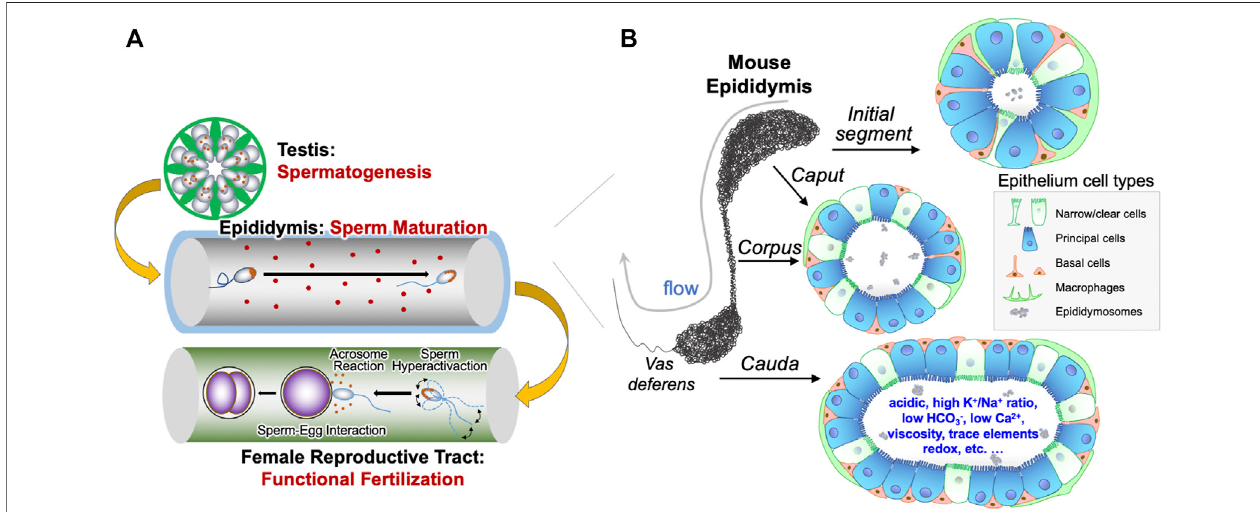
FIGURE 1 | Epididymal epithelial cells and luminal microenvironment are important for malereproduction. (A) Graphic illustration of the generation ofspermatozoa in the testis through spermatogenesis, the maturation of spermatozoa in the epididymis, and the spermatozoa functions, including sperm hyperactivation, acrosome reaction and sperm-egg interaction, in the female reproductive tract required for fertilization. (B) The different cell types in the various regions of epididymis, including basal cells, clear cells, narrow cells, and principal cells, as well as immunological cells from systemic circulation. These different cell types work in a concerted manner to form a unique luminal microenvironment that promotes maturation of sperm during its epididymal transit and ensures male fertility.